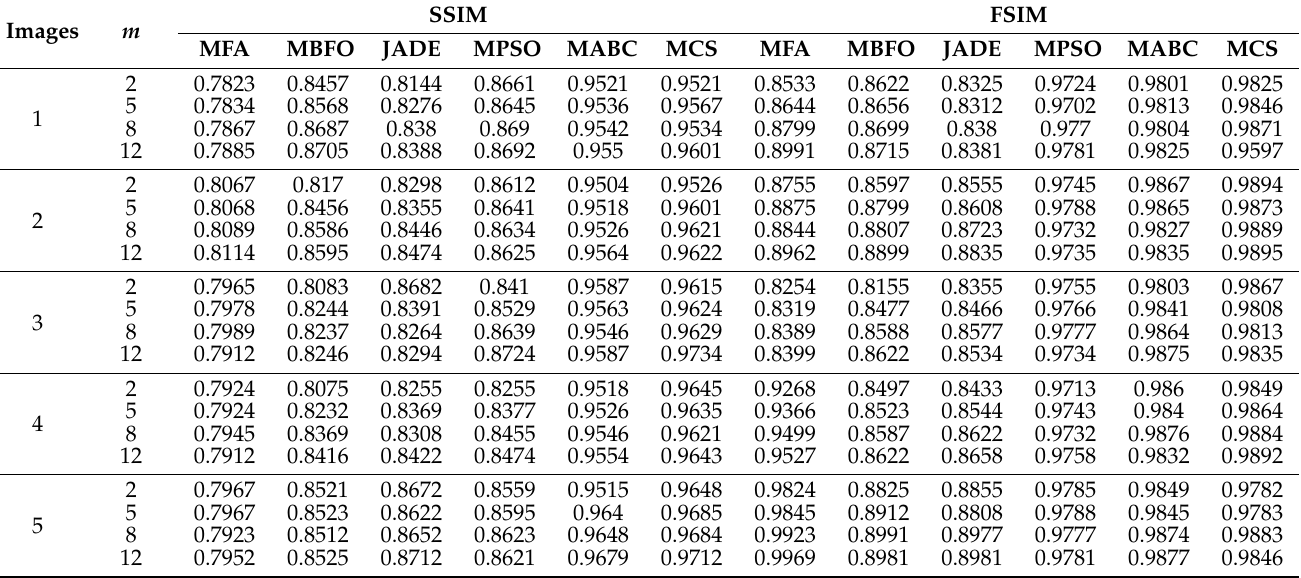
Table A8. SSIM and FSIM computed using different optimization algorithms with the GLCM method. Images